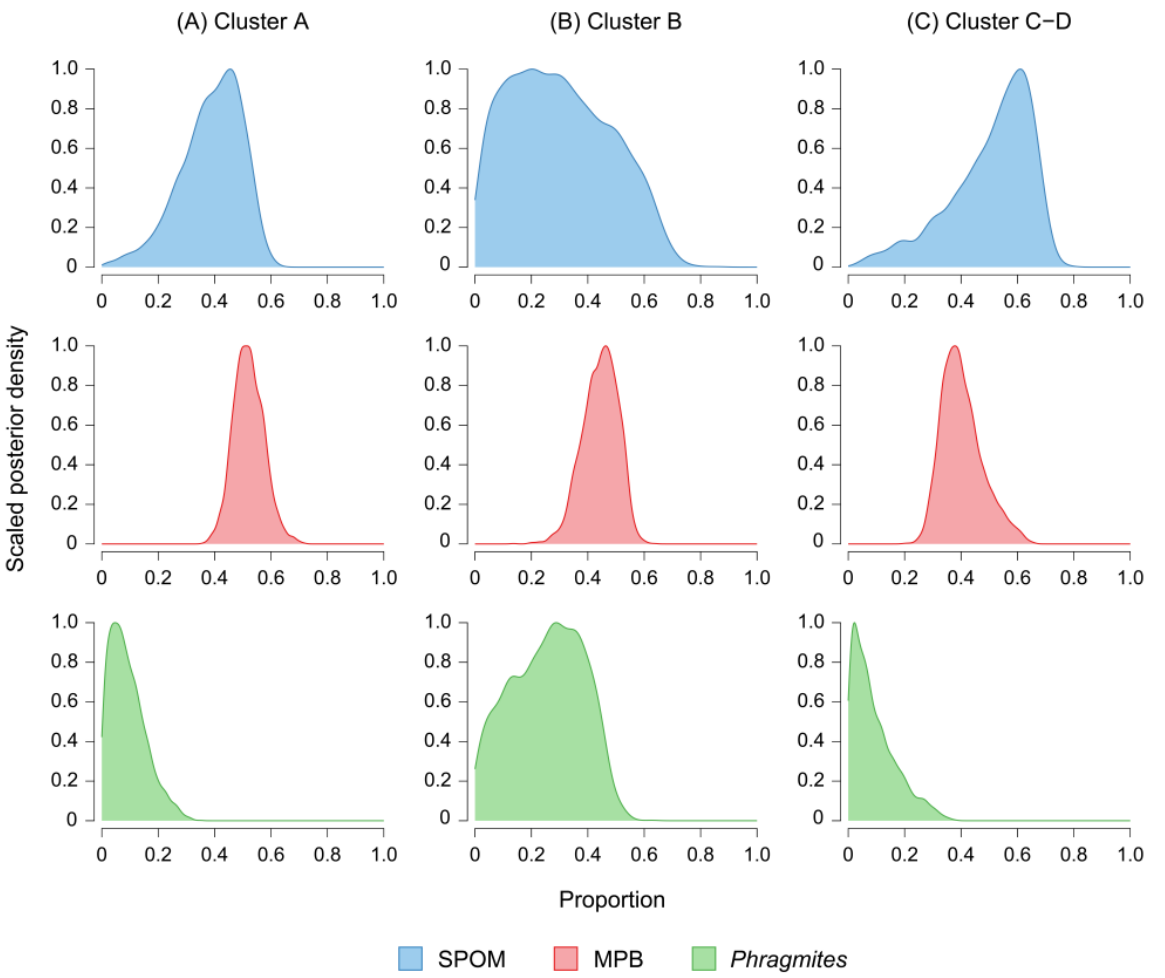
Figure 8. Scaled posterior density of the proportions of the contribution of primary organic matter sources [microphytobenthos (MPB), suspended particulate organic matter (SPOM), Phragmites aus- tralis ] to the nutrition of ark shells in ( A ) clusters A, ( B ) B, and ( C ) C – D, respectively, as calculated using the Bayesian approach of the MixSIAR mixing model.